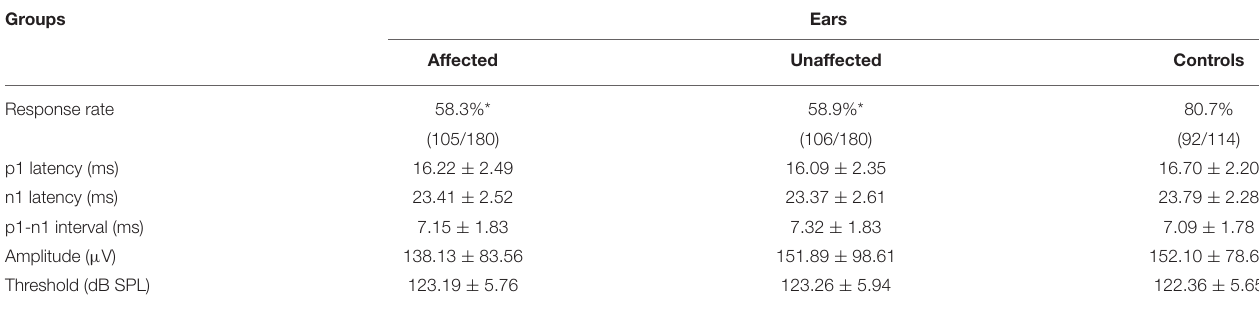
TABLE 4 | Comparison of cervical vestibular-evoked myogenic potential (cVEMP) parameters among affected, unaffected, and control ears. Groups Ears Affected Unaffected Controls Response rate